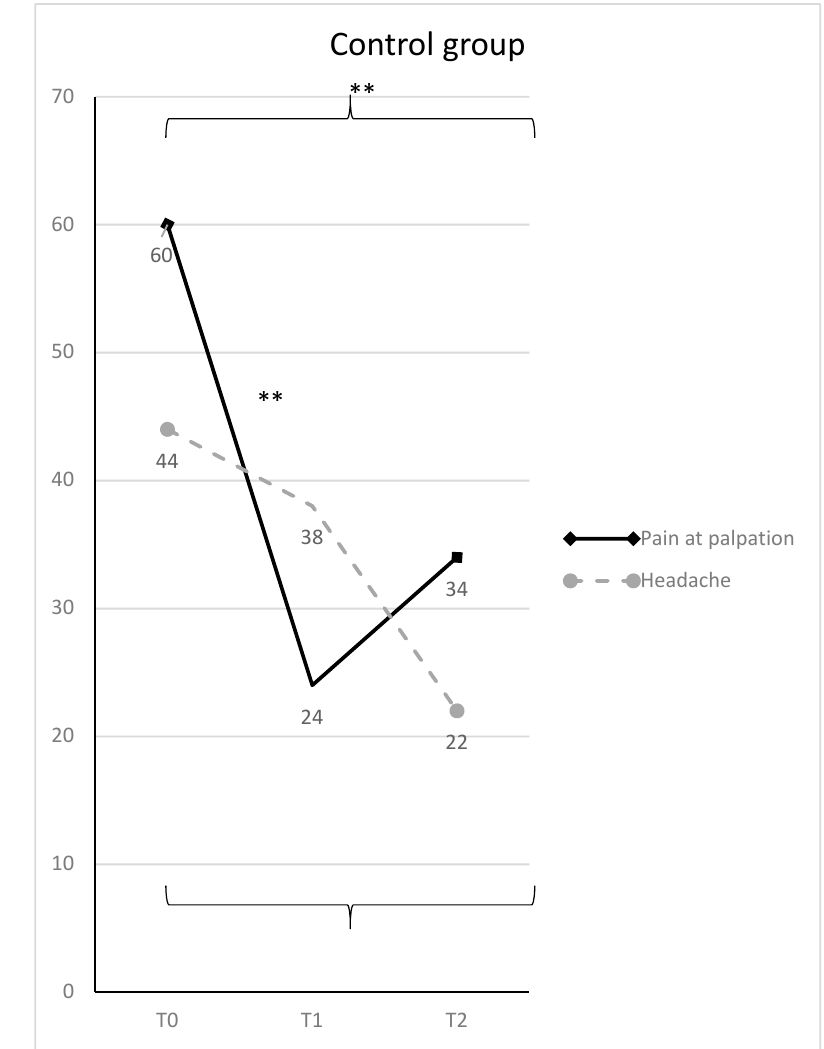
Figure 4. Muscle pain at palpation and headache (mean VAS scores and SD) in the control group, with statistically significant differences overtime (* = p < 0.05; ** = p < 0.01).